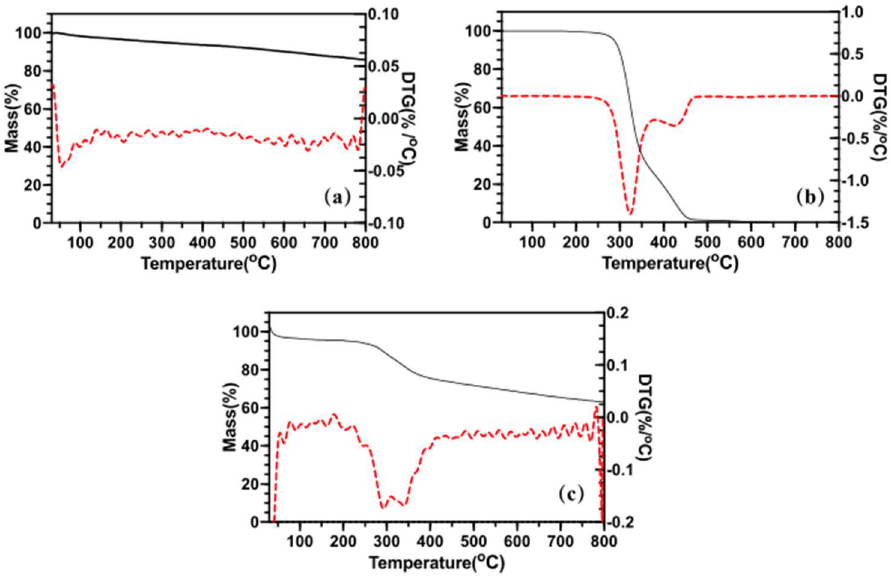
Figure 5. TG–DTG curve of silica aerogel ( a ), pure resveratrol ( b ), and RSA ( c ).